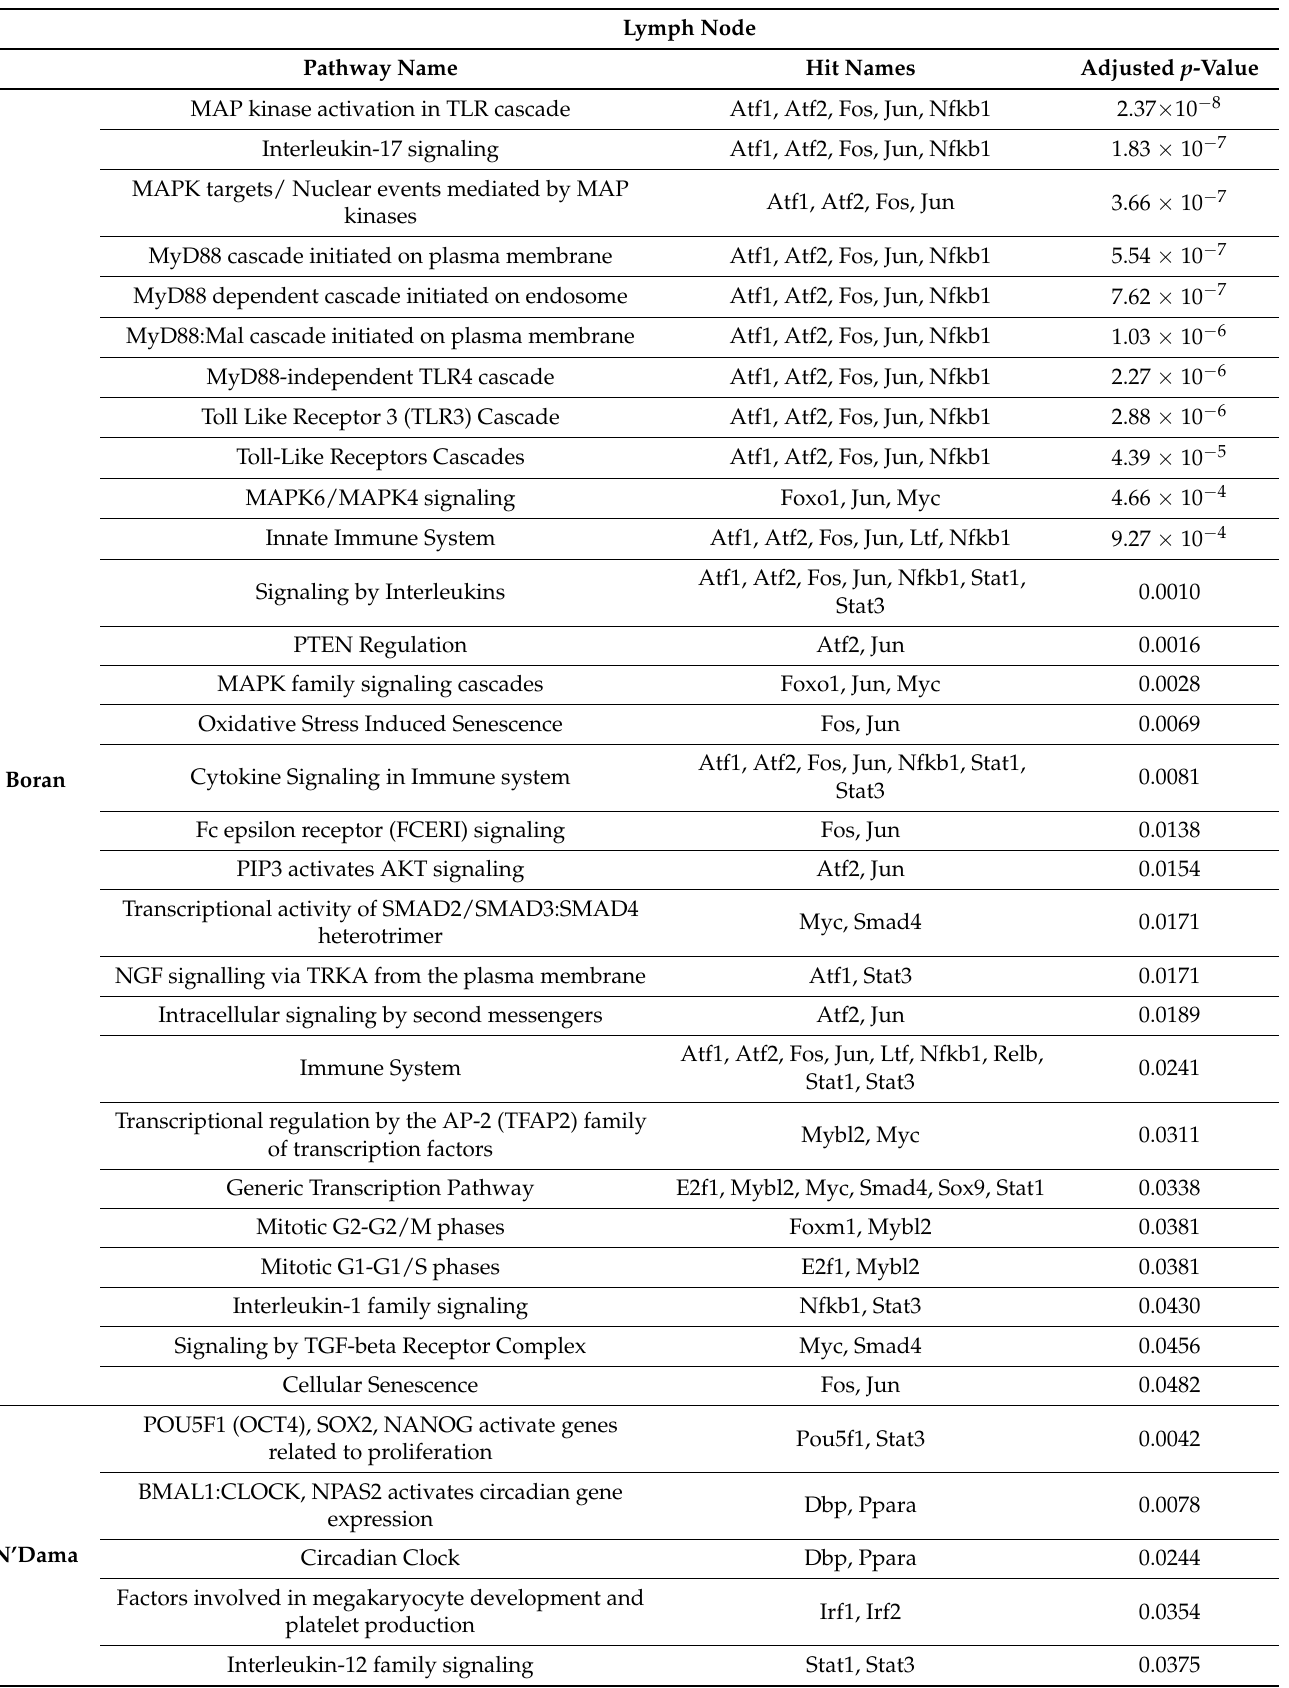
Table 5. Significantly over-represented pathways found for the lymph node tissue of Boran and N’Dama ( p -adjusted <